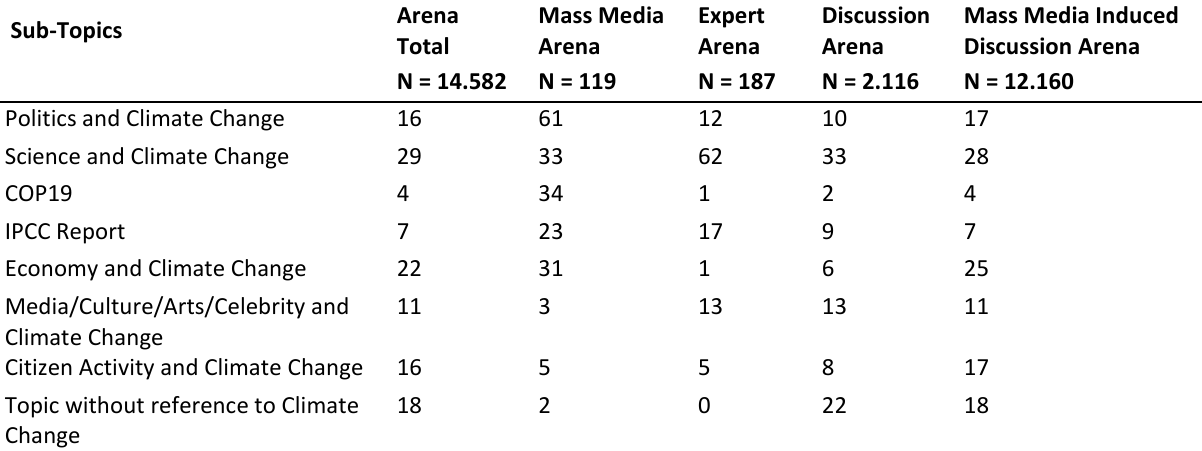
Figure 6. Dynamics of sub-topics during COP19. Table 6. Sub-topic frequencies in different online public arenas (in